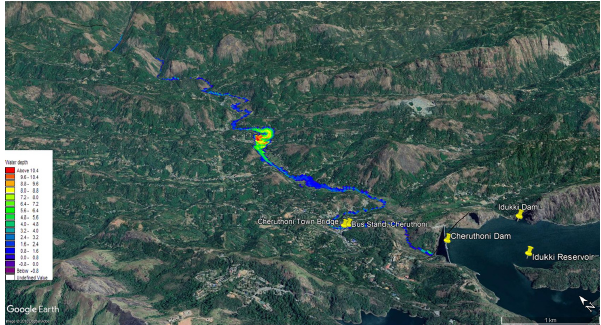
Figure 13 Simulated flood inundation in Periyar River at downstream area of Cheruthoni